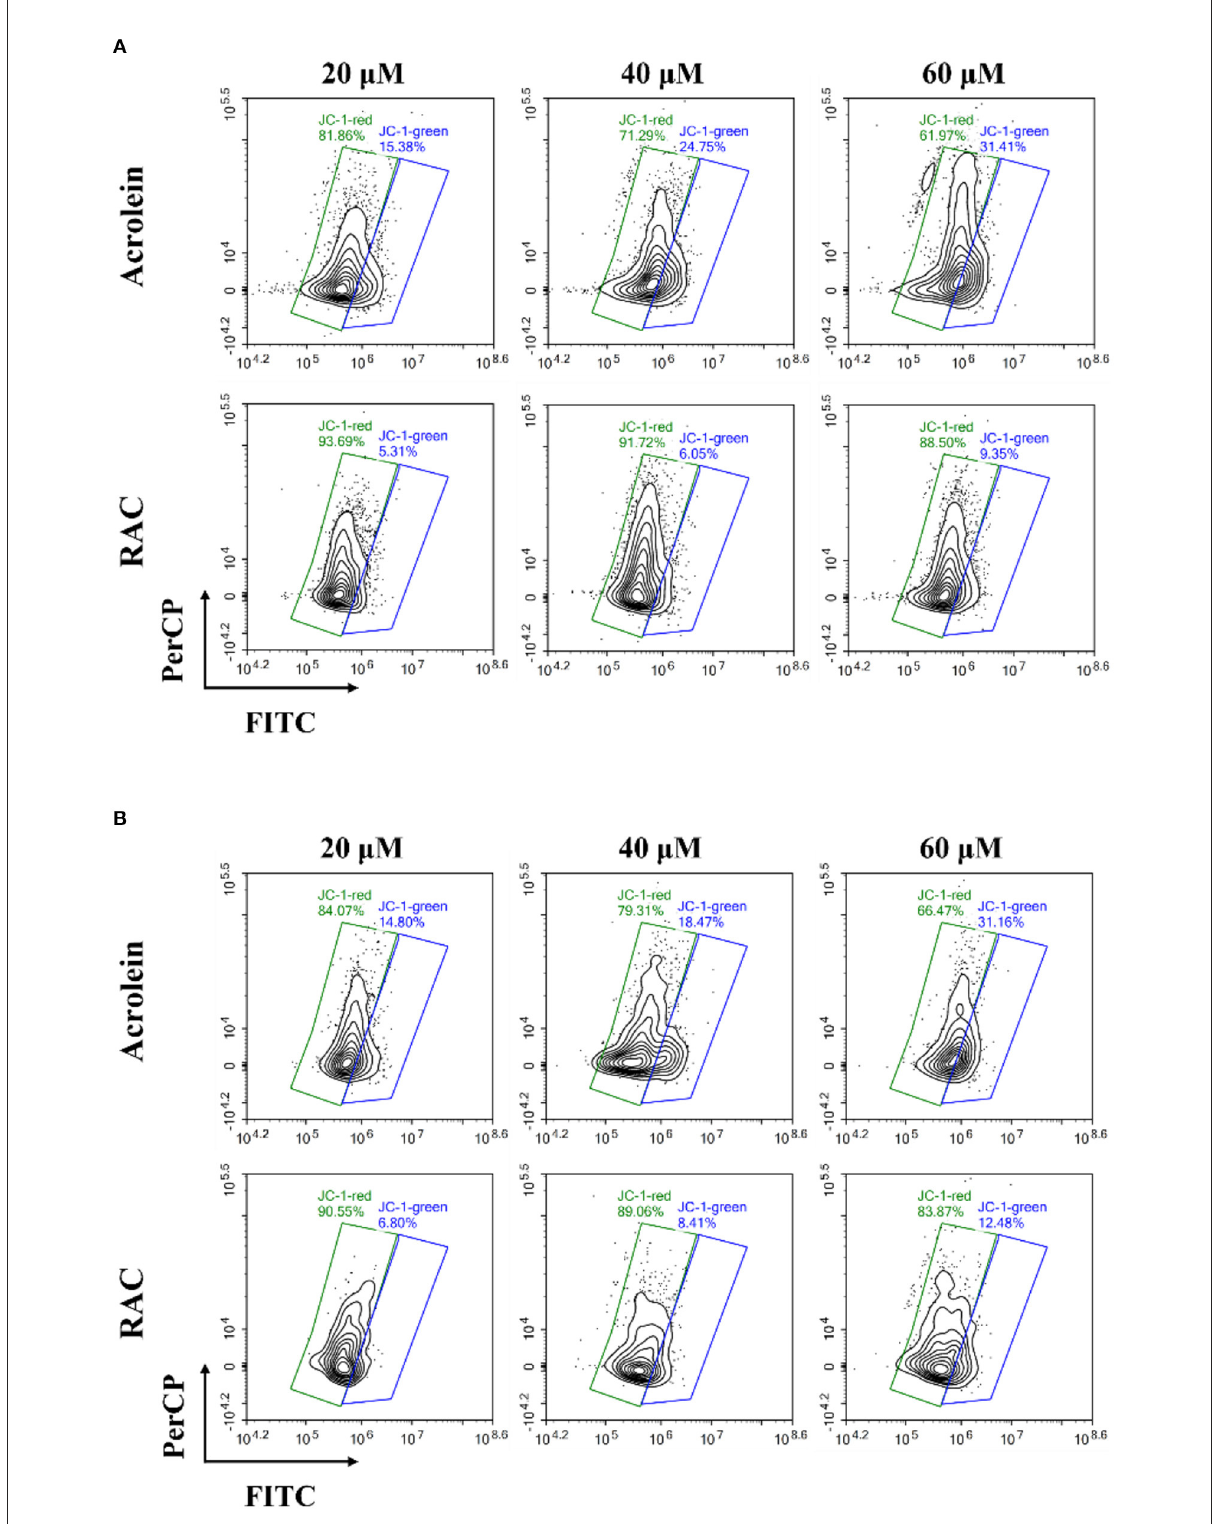
FIGURE7 The changes of the mitochondrial membrane potential (MMP) in (A) Caco-2 and (B) GES-1 cells after incubation with acrolein and RAC at the concentrations of 20, 40, and 60 µ M respectively.